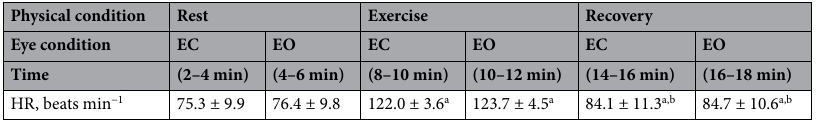
Table 1. Average HR during the experiments. Values are mean ± SD. HR heart rate, EC eye closed, EO eye open. a p < 0.01, vs. rest (2–6 min). b p < 0.01 vs exercise (8–12